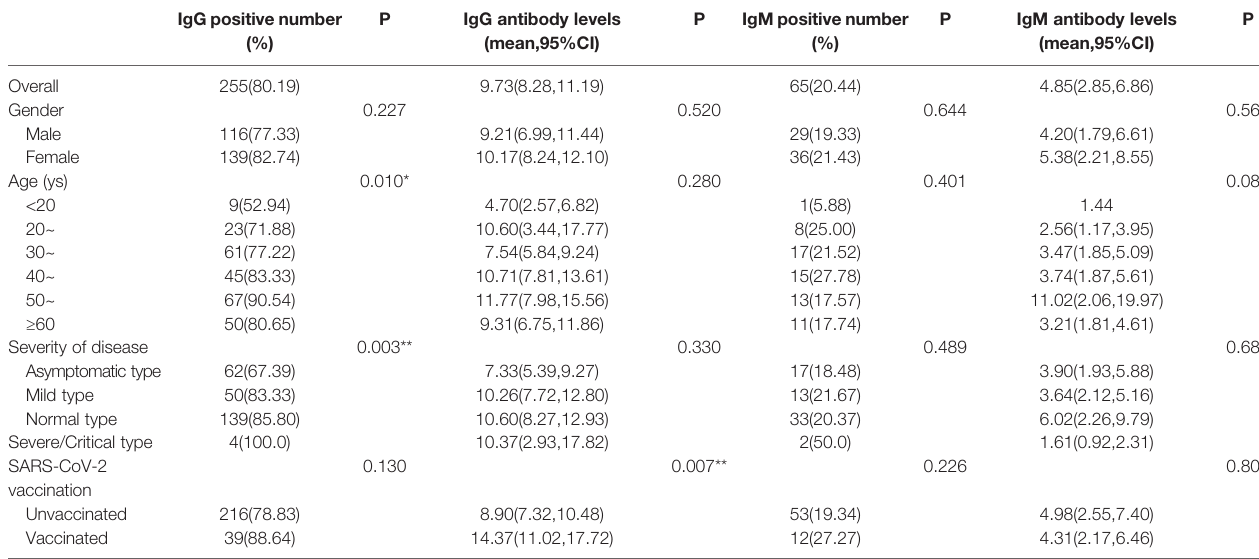
TABLE 2 | Distribution of IgM/IgG among overall convalescent patients.